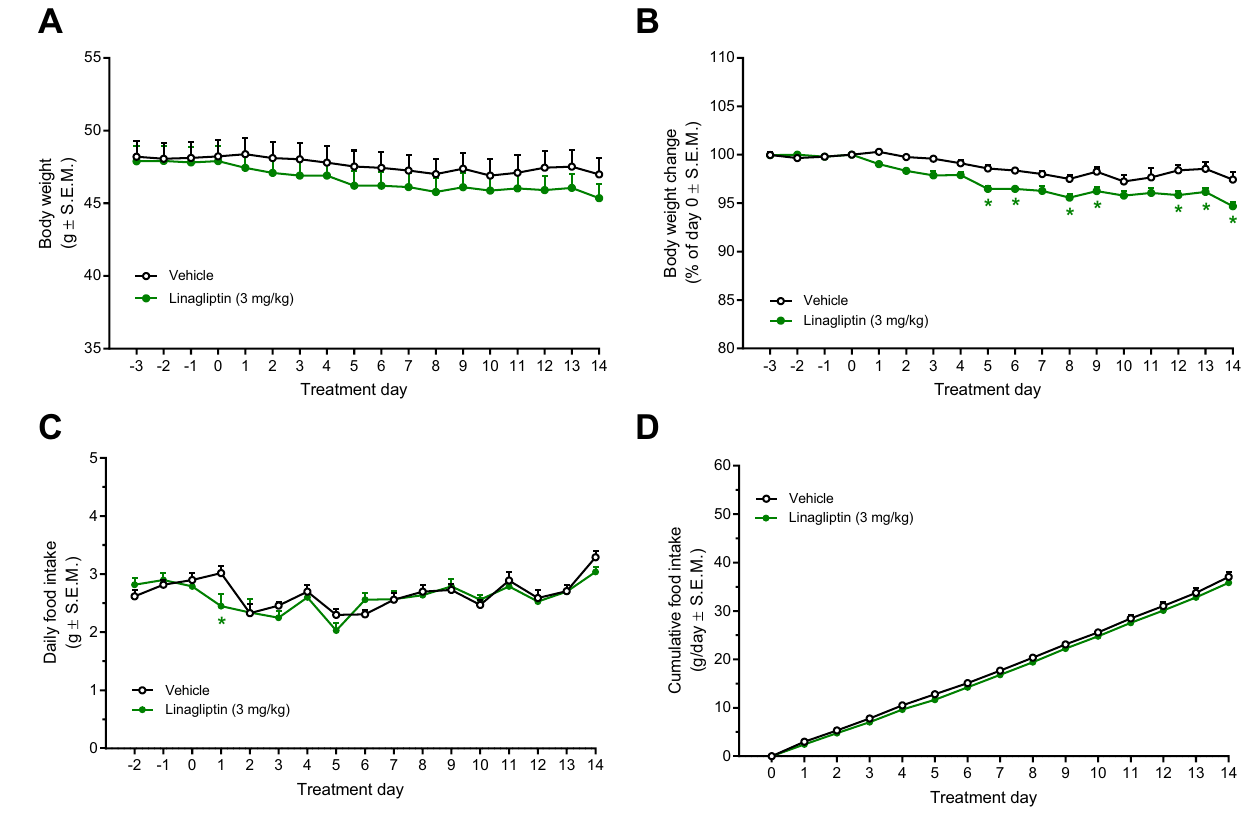
Figure 1. Linagliptin promotes marginal weight loss without influencing high-fat diet intake in DIO mice. *p < 0.05 vs. vehicle controls (two-way ANOVA with Dunnett’s post-hoc